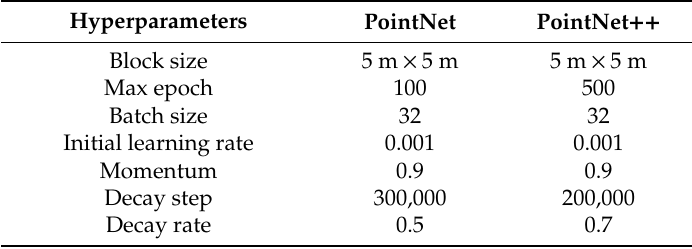
Table 8. Model parameters and corresponding values for PointNet and PointNet ++